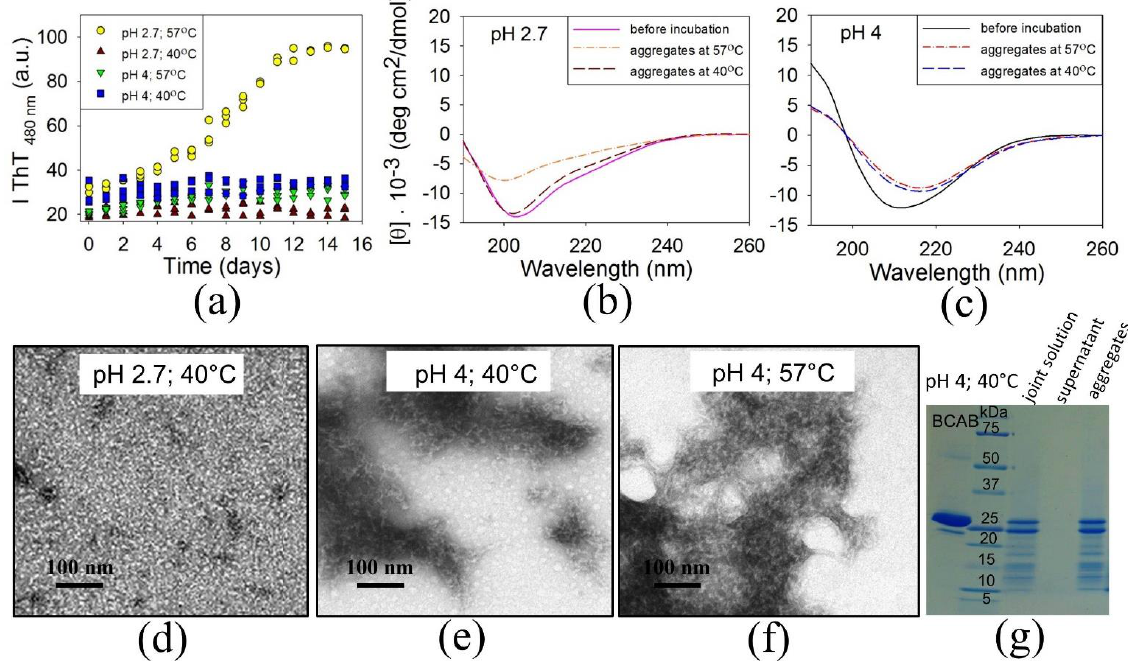
Figure 6. Time dependence of thioflavin T fluorescence after dye addition to BCAB solutions incubated at pH 2.7 and pH 4 at two different temperatures, 57 °C, and 40 °C (for each condition, three repeated experiments have been carried out) ( a ). Far UV CD spectra of BCAB before incubation and after 15 days of incubation at pH 2.7 ( b ) and at pH 4 ( c ). Electron micrographs of aggregates formed by BCAB after incubation during 15 days at pH 2.7 and 40 °C ( d ), at pH 4 and 40 °C ( e ), at pH 4 and 57 °C ( f ). SDS-PAGE electrophoregram of BCAB solution after 15 days of incubation at рН 4 and 40 °C ( g ).